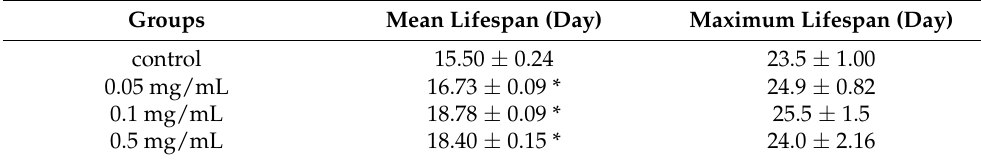
Table 3. Impact of SPO on the lifespan of C. elegans .